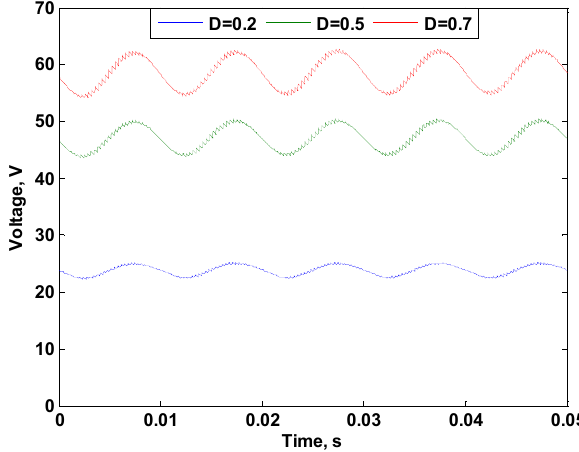
Figure 35. Experimental output voltages at the load terminals at the adopted duty ratios.